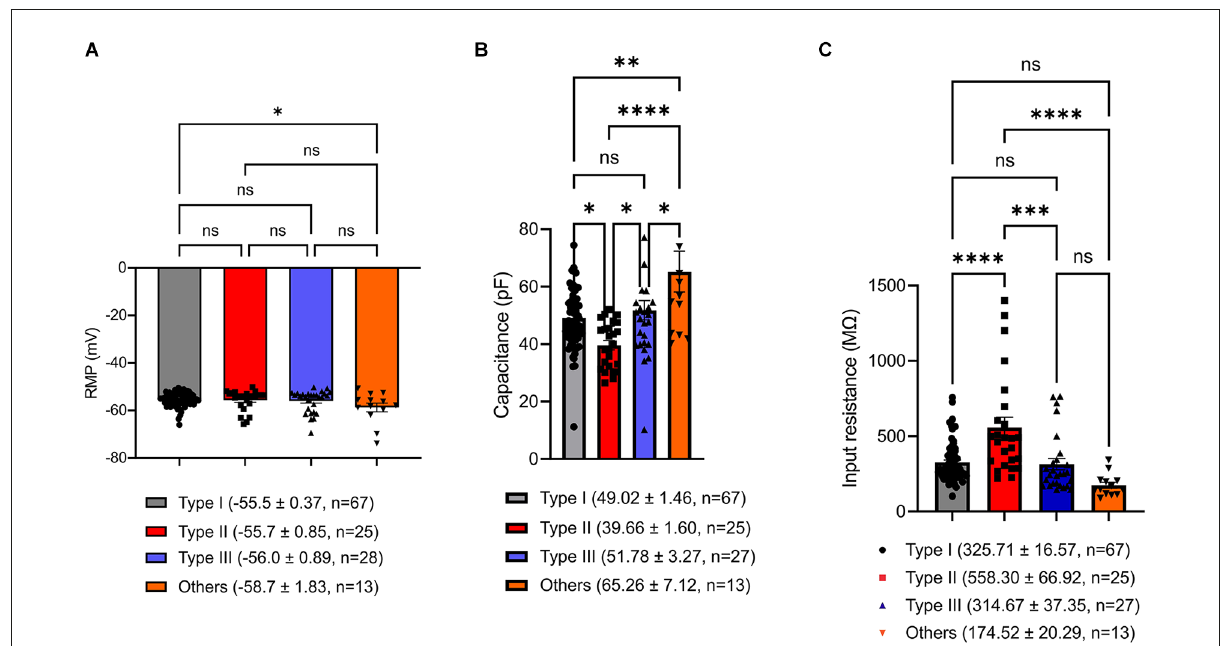
FIGURE7 Passive membrane properties of VTA projecting BNST neurons. (A) Resting membrane potential (RMP). Type “Others” exhibit significantly hyperpolarized RMP compared to Type I (adjusted P = 0.0482). (B) Capacitance. Type “Others” have significantly larger capacitance compared to Type I, Type II, and Type III (adjusted P = 0.0018, vs. Type I; adjusted P < 0.0001, vs. Type II; adjusted P = 0.0333, vs. Type III). (C) Input resistance. Type II neurons have significantly higher input resistance than Type I, Type III, and Type “Others” (adjusted P < 0.0001, vs. Type